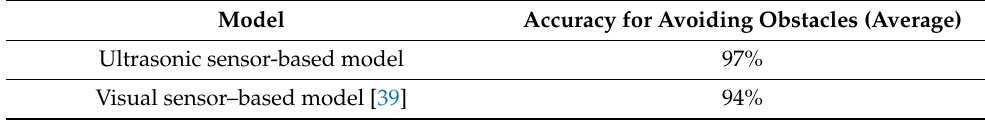
Table 6. Comparative results for different type of sensors for obstacle